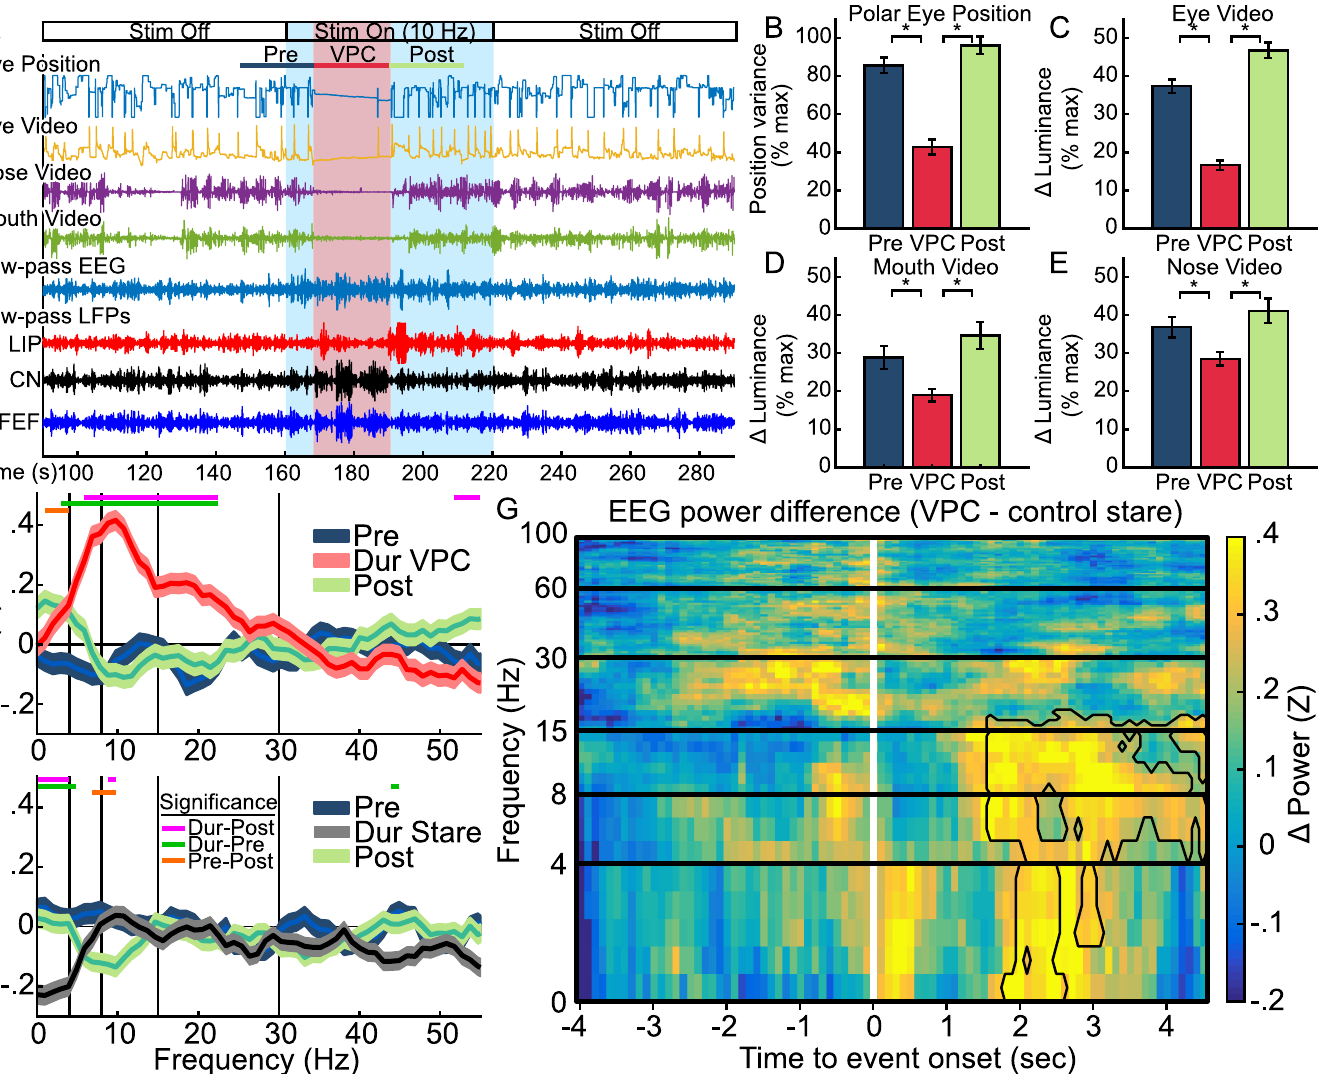
Fig 4. Thalamic DBS triggers periods of behavioral stillness coinciding with low-frequency activity in the EEG, similar to absence epilepsy. A , Example time course of behavioral and neural signatures of a VPC event initiating after 10Hz stimulation. B,C,D,E, Average behavioral signatures during VPC relative to pre and post conditions ( ± SE) for the ( B) variance in polar eye position from eye tracker, and change in luminance for video data centered on the ( C ) eyes, ( D ) mouth, and ( E ) nose. Luminance changes indicate movement. F , Average EEG power ( ± SE) for VPC and control stares compared to pre and post conditions. Colored straight lines at top indicate regions of significance for t-tests across frequencies comparing spectra from the different conditions. Vertical black lines indicate the cutoff mark of different frequency bands: δ = (0, 4), θ = (4, 8), α = (8, 15), β = (15, 30), γ L = (30, 60), γ H = (60, 100). G , Spectrogram of average differences in normalized EEG power (VPC–control stare) aligned to event onset (white line). Frequency is represented across described power bands. Significant cluster outlined in